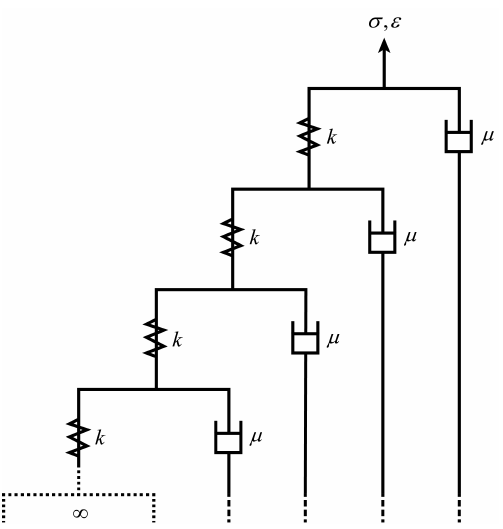
Figure 3. The fractal tree of self-identical components abstracted from the straight